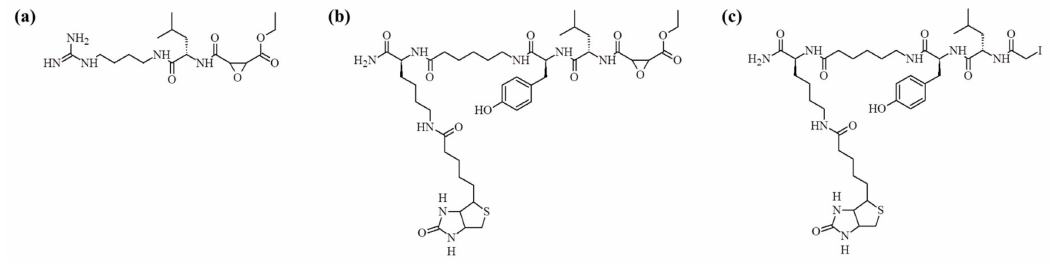
Figure 1. Chemical structures of cysteine proteases inhibitors. ( a ) E-64, ( b ) DCG-04, and ( c ) novel inhibitor.